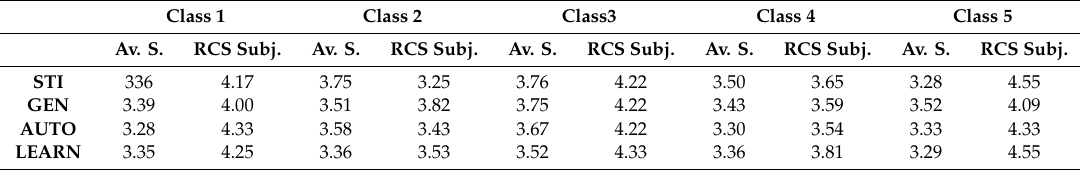
Table 1. Descriptive statistic results of the evaluations of the subjects with and without RCS in